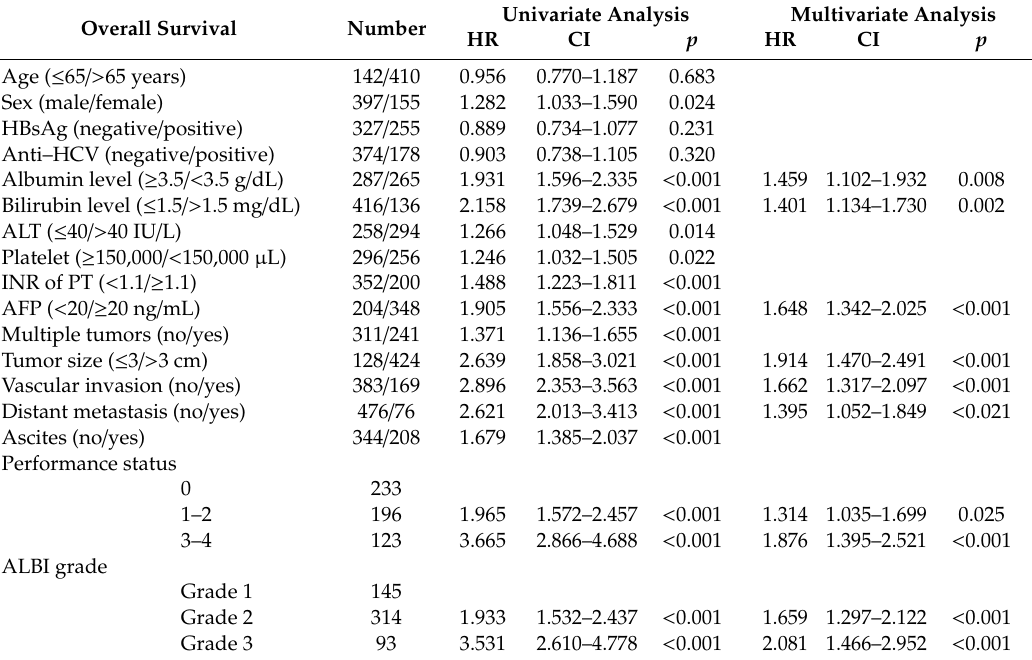
Table 5. Univariate and multivariate survival analysis in HCC patients with renal insu ffi ciency undergoing non-curative treatment ( n =